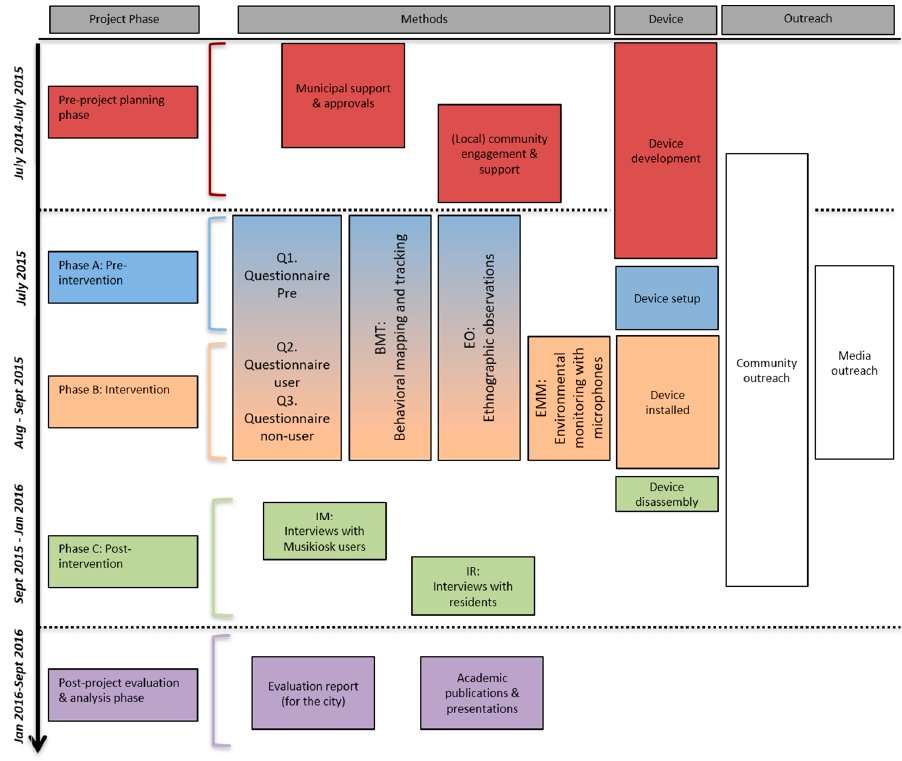
Figure 2. Musikiosk research timeline by phase. Legend indicates method type.